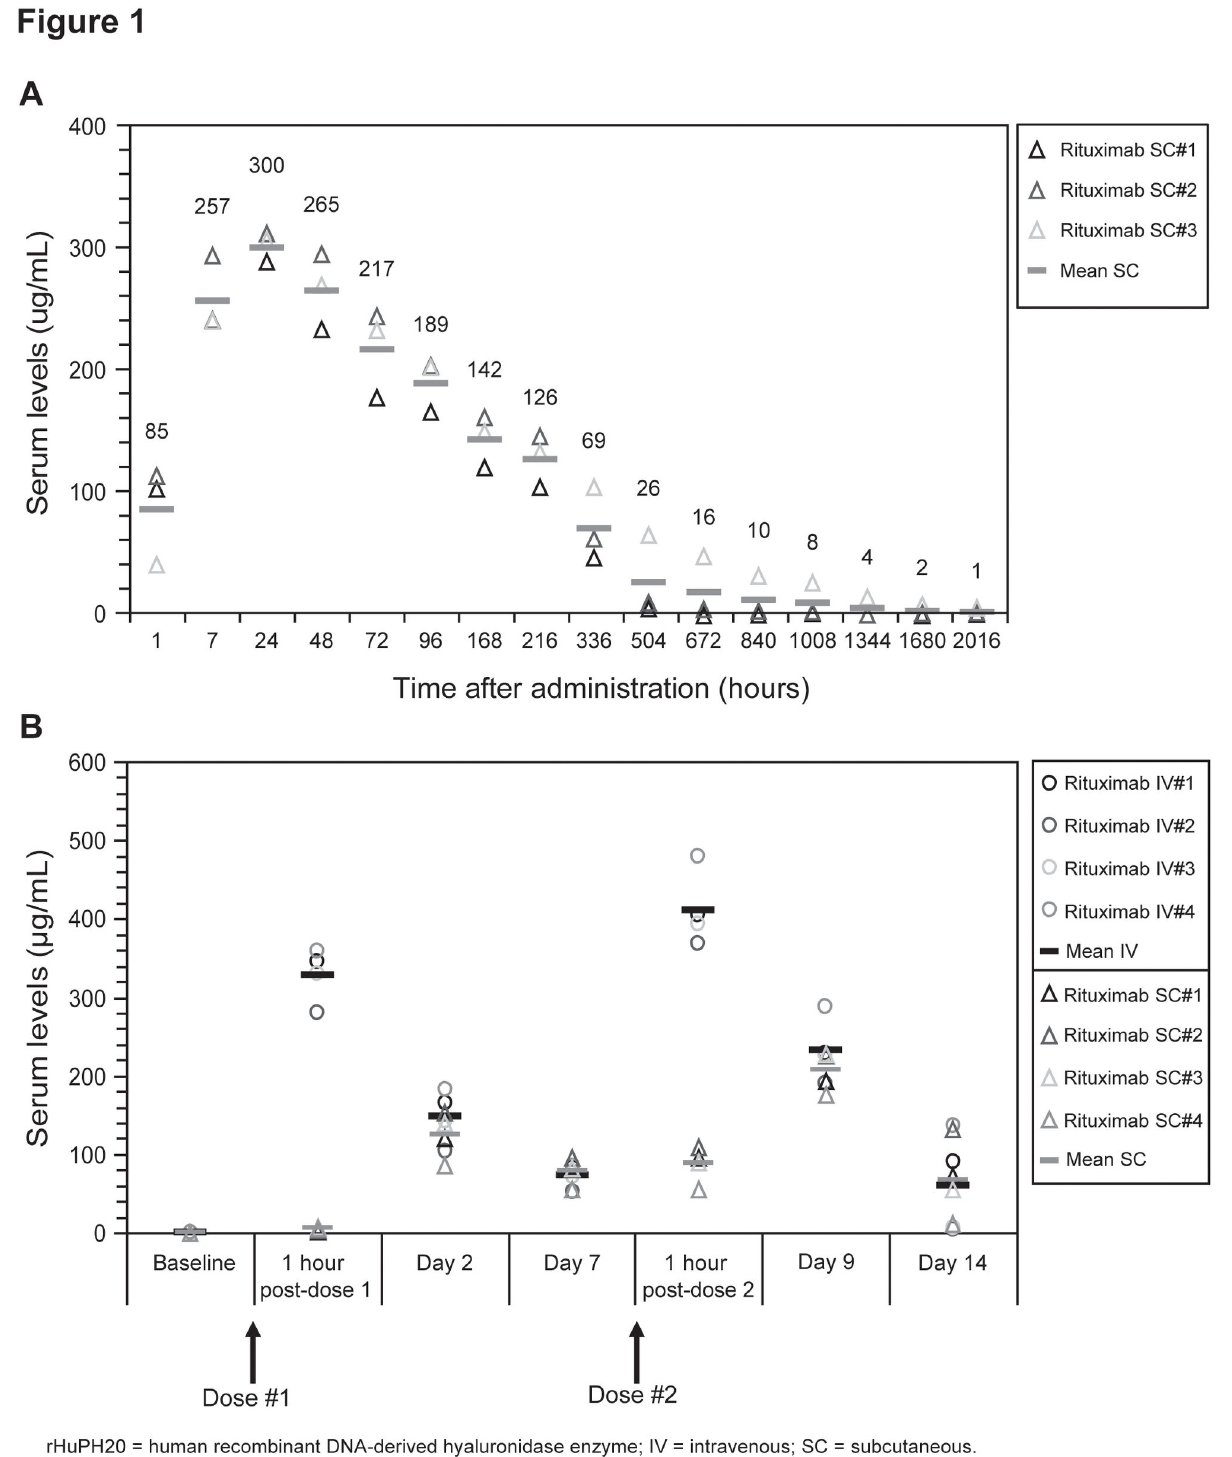
Figure 1. Pharmacokinetics of serum rituximab in cynomolgus monkeys. PK analysis of serum rituximab levels after ( A ) a single SC dose of rituximab preformulated in rHuPH20 administered at 20 mg/kg (Individual animal samples with mean score shown (n=3)), and ( B ) 2 × 10 mg/kg doses of SC (preformulated in rHuPH20) or standard IV rituximab, given 7 days apart (Individuals animal samples with mean shown (n=4)). doi: 10.1371/journal.pone.0080533.g001 PLOS ONE |